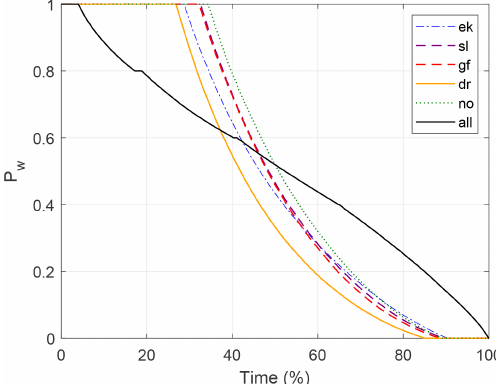
Figure 7. Generation duration curve (GDC) for the five sites and the interconnected system (“all”).